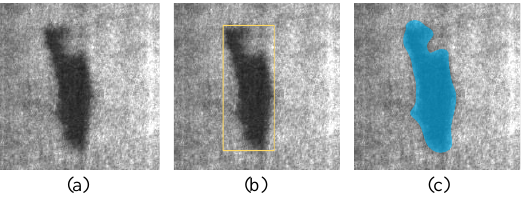
Figure 1. Three kinds of surface defect detection tasks. ( a ) Image-level defect classification task. ( b ) Region-level defect detection. ( c ) Pixel-level defect